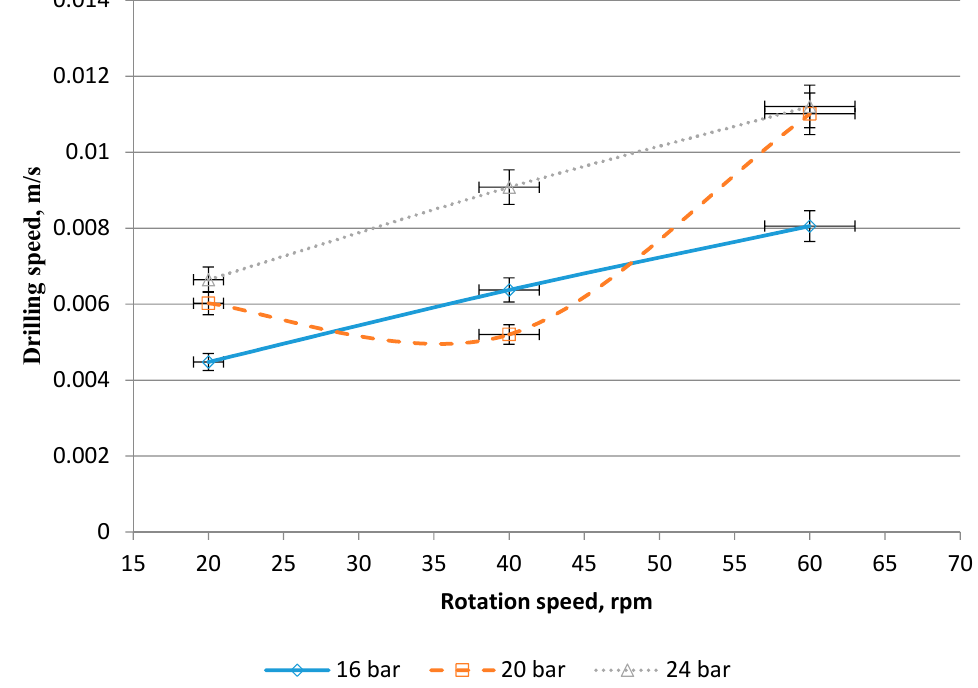
Figure 13. Variation of drilling velocity with rotation speed for several pressures (shown in the legend below the figure), for the 140 mm diameter drill bit, an interval of 90–108 m below the ground level, and boreholes 7–9.